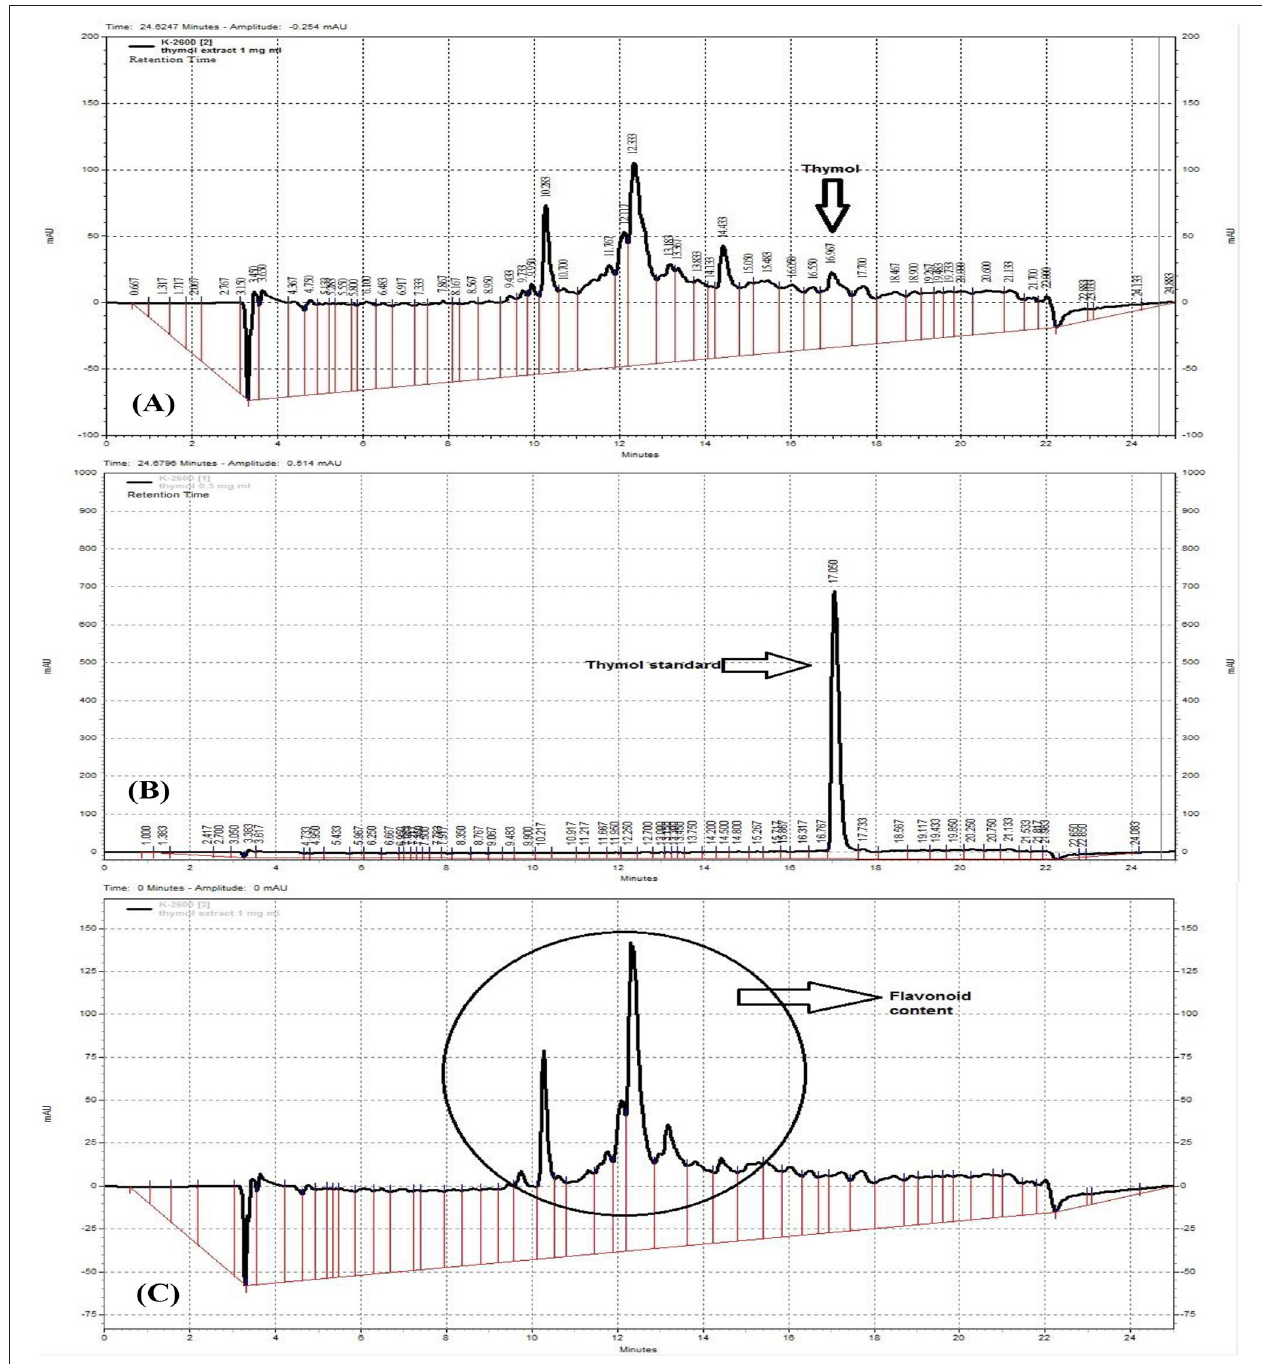
FIGURE 2 | RP-HPLC fingerprinting analysis of Z. multiflora extract (A,C) at 280 and 320 nm (C) , thymol standard curve (B) . The presence of flavonoids was confirmed at the wavelength 320 nm which is specific for flavonoids and on the basis of previous works.